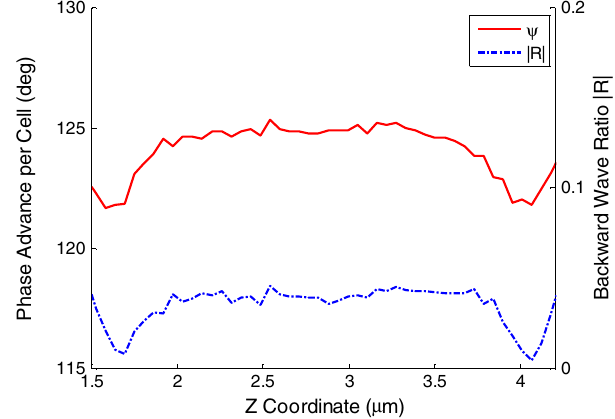
FIG. 10. Phase advance per cell ψ and normalized backward wave amplitude j R j of an 8-cell power coupler structure, proving it is traveling-wave matched to the new woodpile accelerating